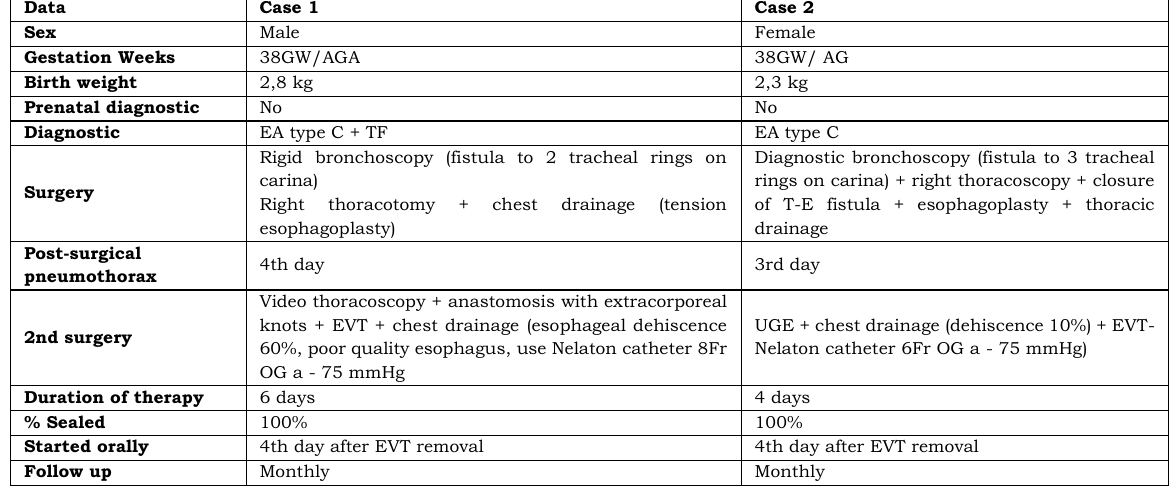
Table 1: Summary of cases presented.